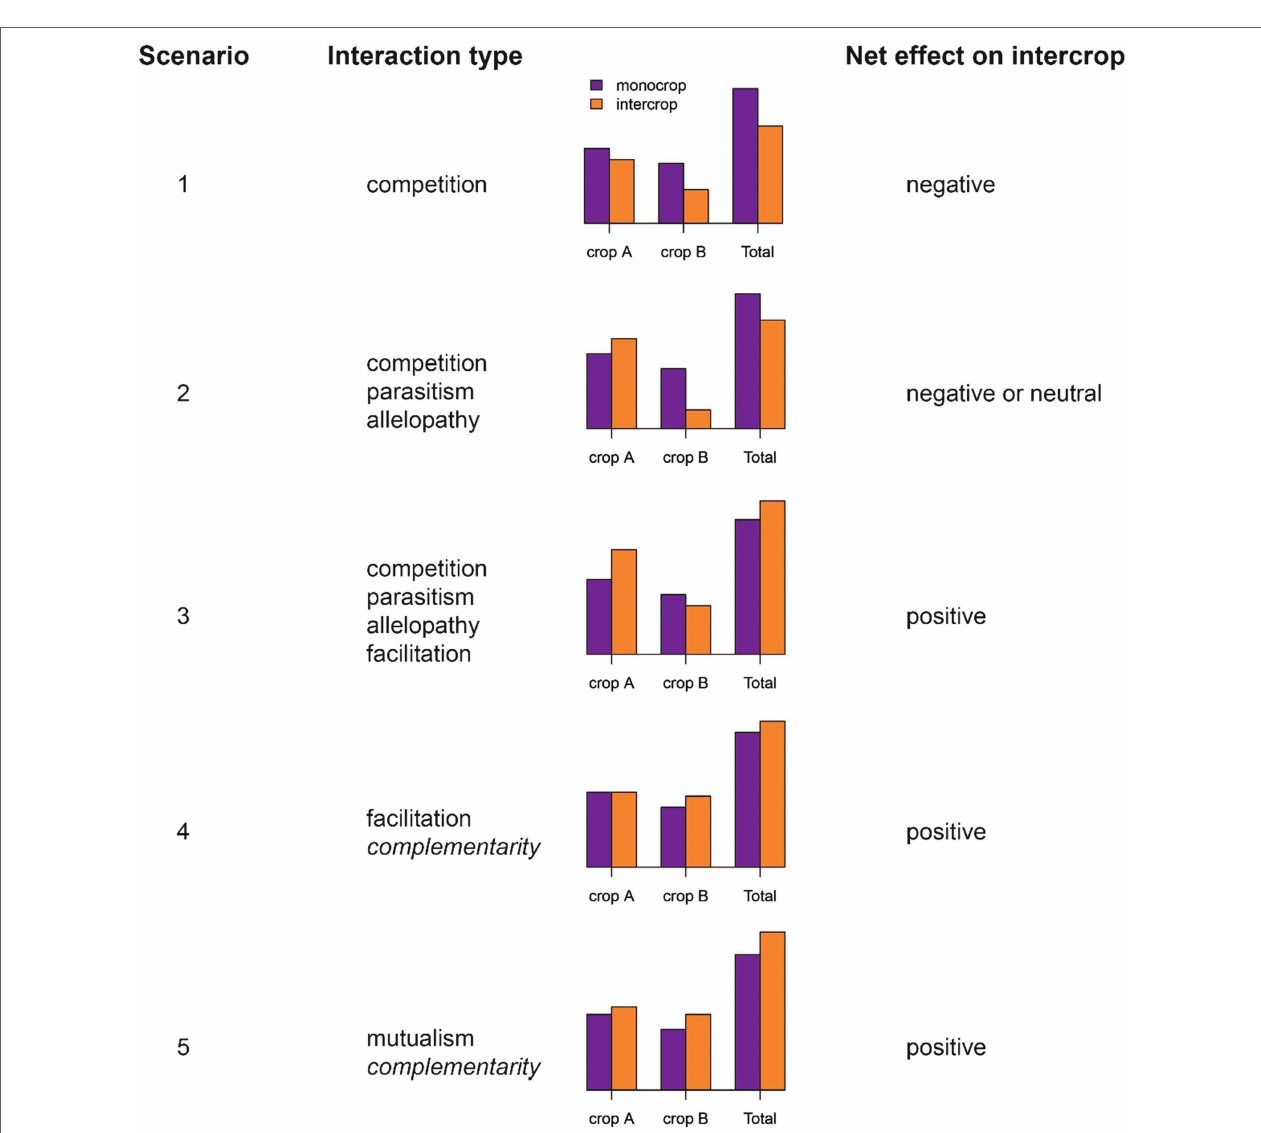
FIGURE 1 | Types of inter-specific plant-plant interactions. Five scenarios are depicted with contrasting net effects on intercrop performance (for example, the economic value of the combination of crops). “Interaction type” includes the terms used to describe the nature of the interaction, summarized from Dudley (2015). Complementarity is omitted from Dudley’s